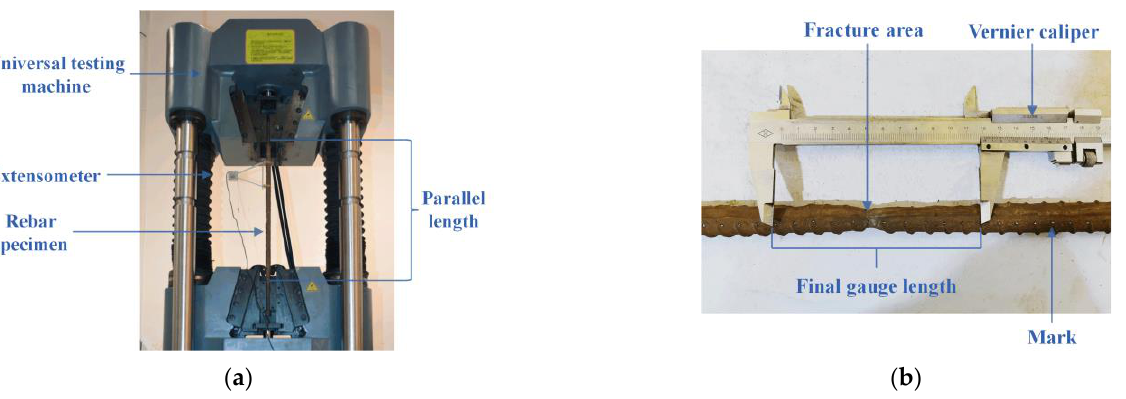
Figure 3. Tensile test set-up and testing: ( a ) loading arrangement; ( b ) measuring elongation.